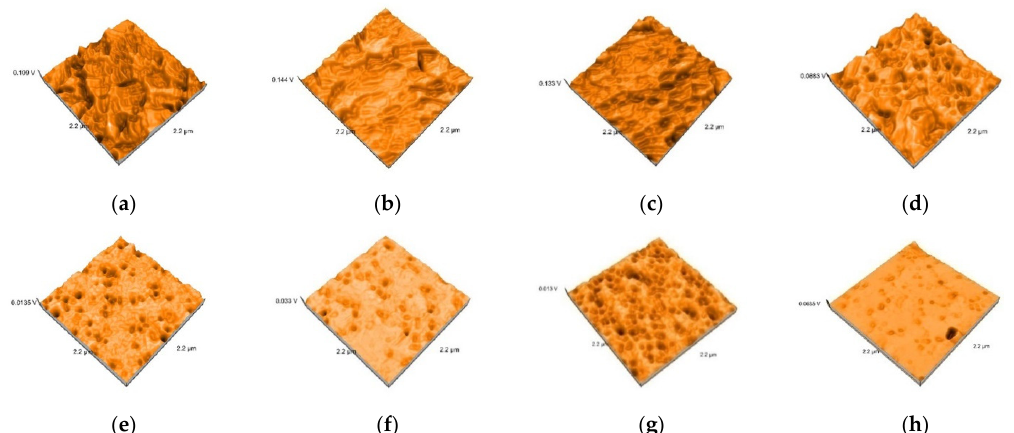
Figure 5. 3D images of Cerasmart specimens: ( a ) Cerasmart-tribochemical silica airborne particle abrasion ( b ) Cerasmart sandblasted, ( c ) Cerasmart etched, ( d ) Cerasmart polished, ( e ) Cerasmart-tribochemical silica airborne particle abrasion and glazed, ( f ) Cerasmart sandblasted glazed, ( g ) Cerasmart etched glazed, ( h ) Cerasmart polished glazed.